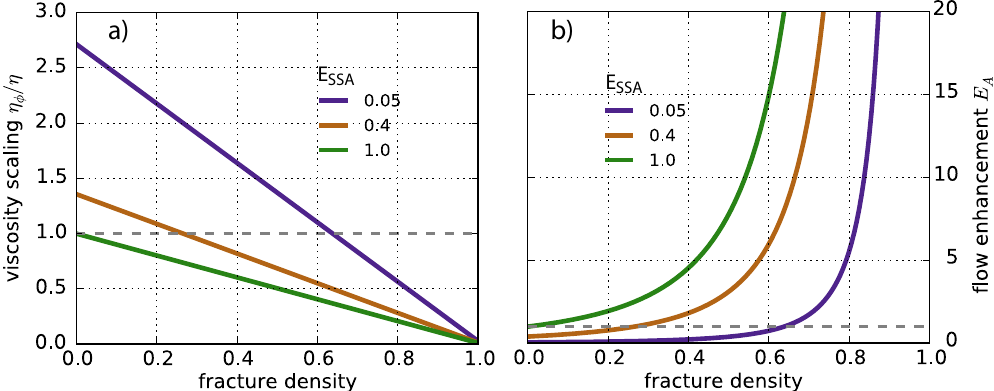
Fig. 1. Functional relationship of viscosity (a) and ice softening (b) with respect to fracture density as in Eq. (6) is shown for three SSA- enhancement factors E SSA (see legend). Base line for E SSA = 1 is grey